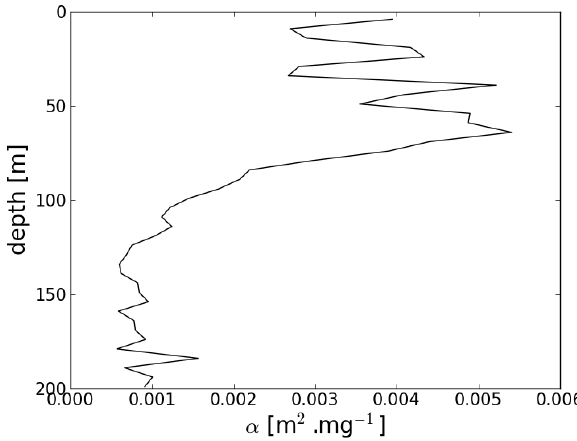
Fig. 9. Vertical evolution of the coefficient α ( b bp = α TChl- a β ) calculated from a regression analysis performed at different depths between the b bp and TChl- a data values measured at the three long duration Figure 9.